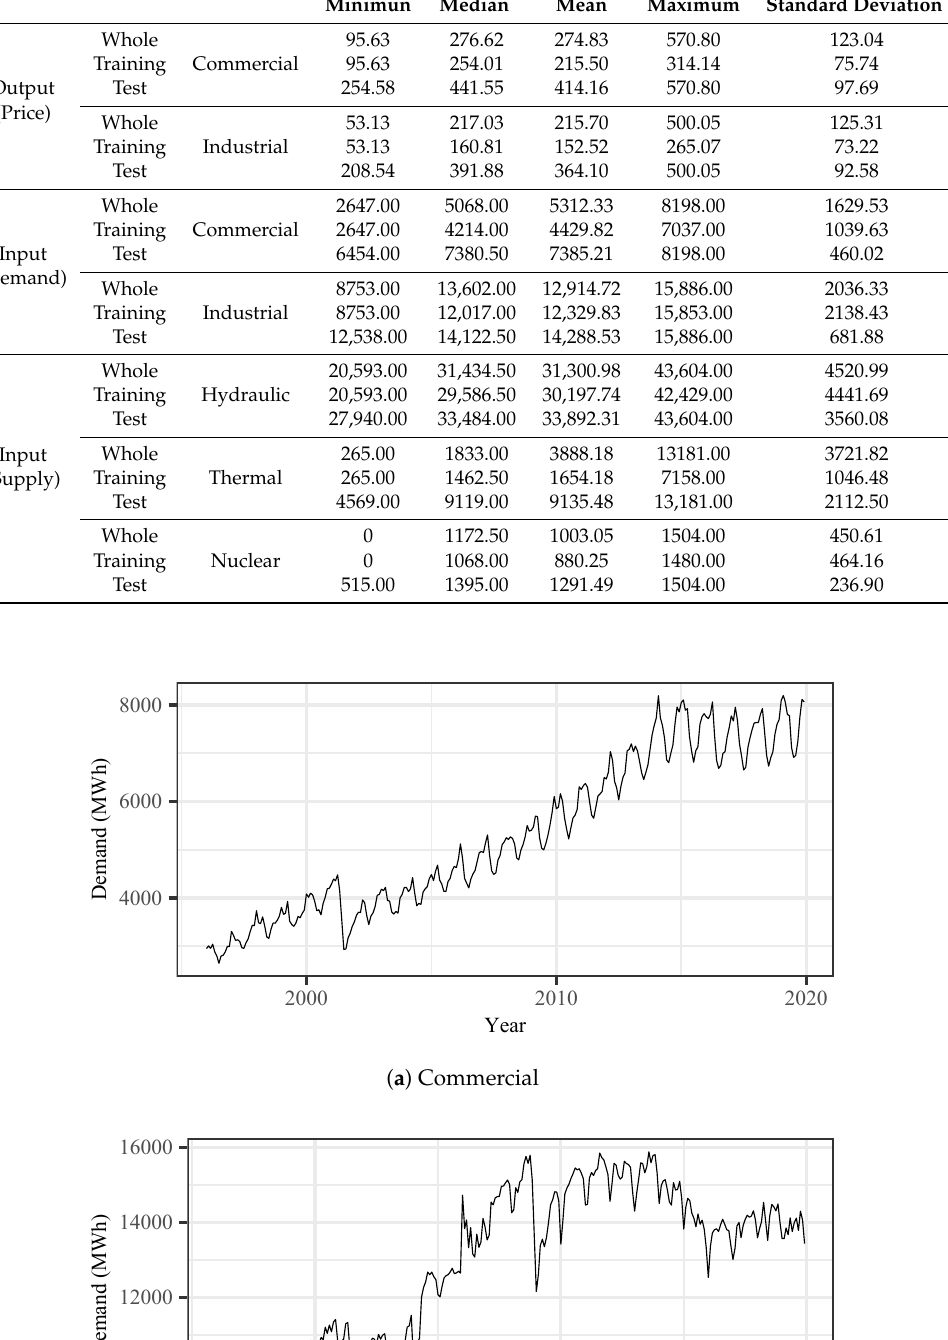
Table 1. Descriptive measures for Brazilian commercial, industrial electricity price, and exogenous variables. Variable